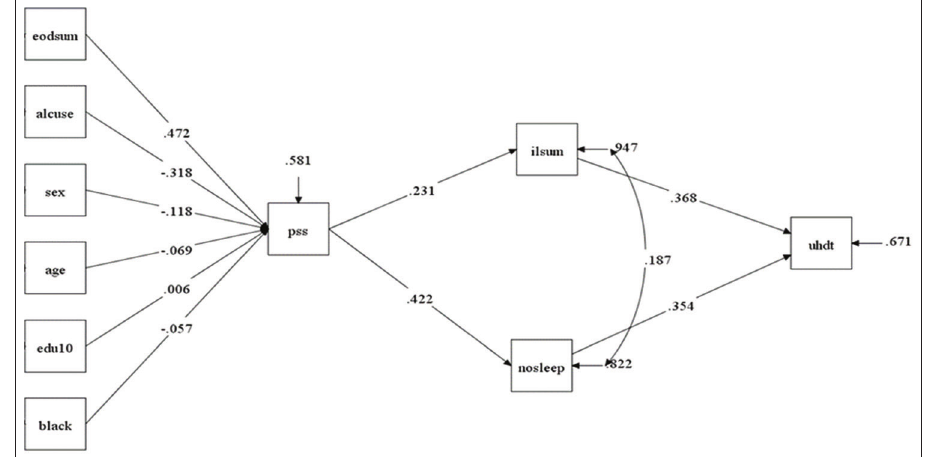
Figure 1: Standardized coefficients for the relationship between experiences of discrimination (eodsum) and unhealthy days (uhdt) through the mediation of stress (pss) and sleep (nosleep). Alcuse = alcohol use; edu10 = education; ilsum = chronic